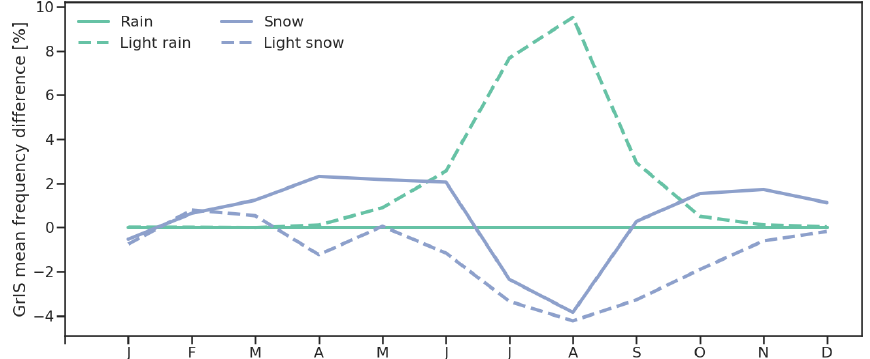
Figure 10. Greenland Ice Sheet averaged snowfall and light snowfall (blue: solid, dashed) and rainfall and light rainfall (green: solid, dashed) frequency difference between future (2080–2095) and present (2006–2020), as simulated by CESM.